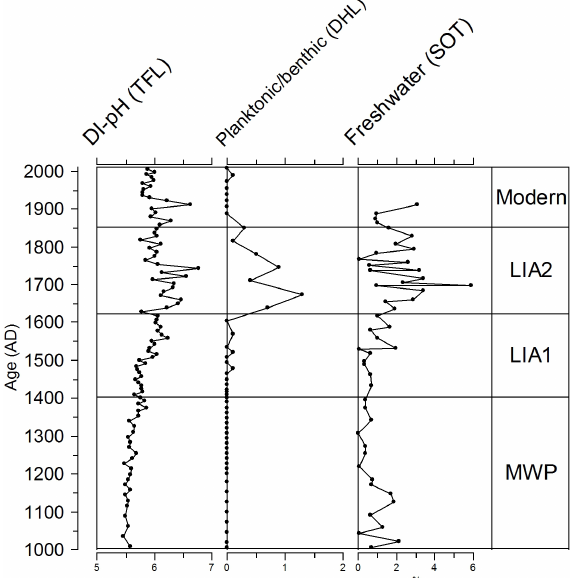
Figure 8. Variations of diatom-inferred precipitation during the last 1000 years in subalpine lake (TFL) (Wang et al., 2013), lowland lake (DHL), and offshore marine sediments (SOT) (Li et al.,